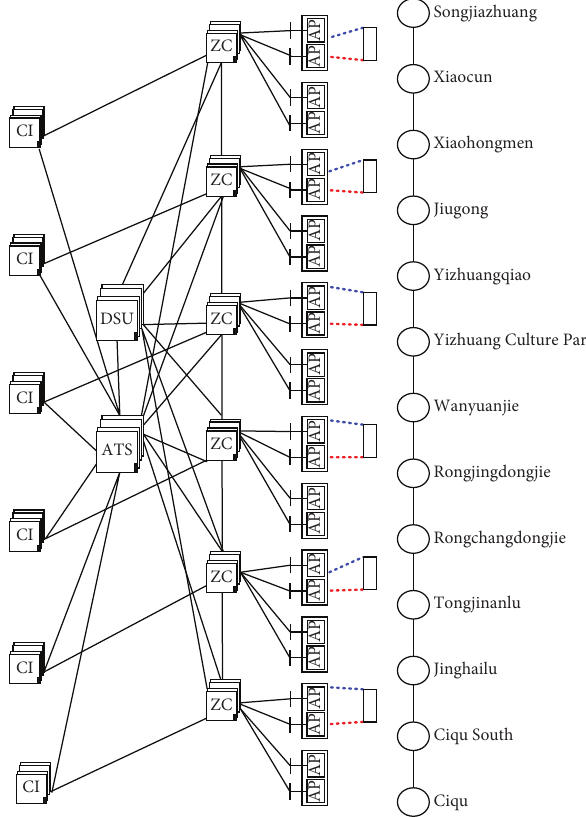
Figure 3: The computer network of Beijing Subway Yizhuang Line.